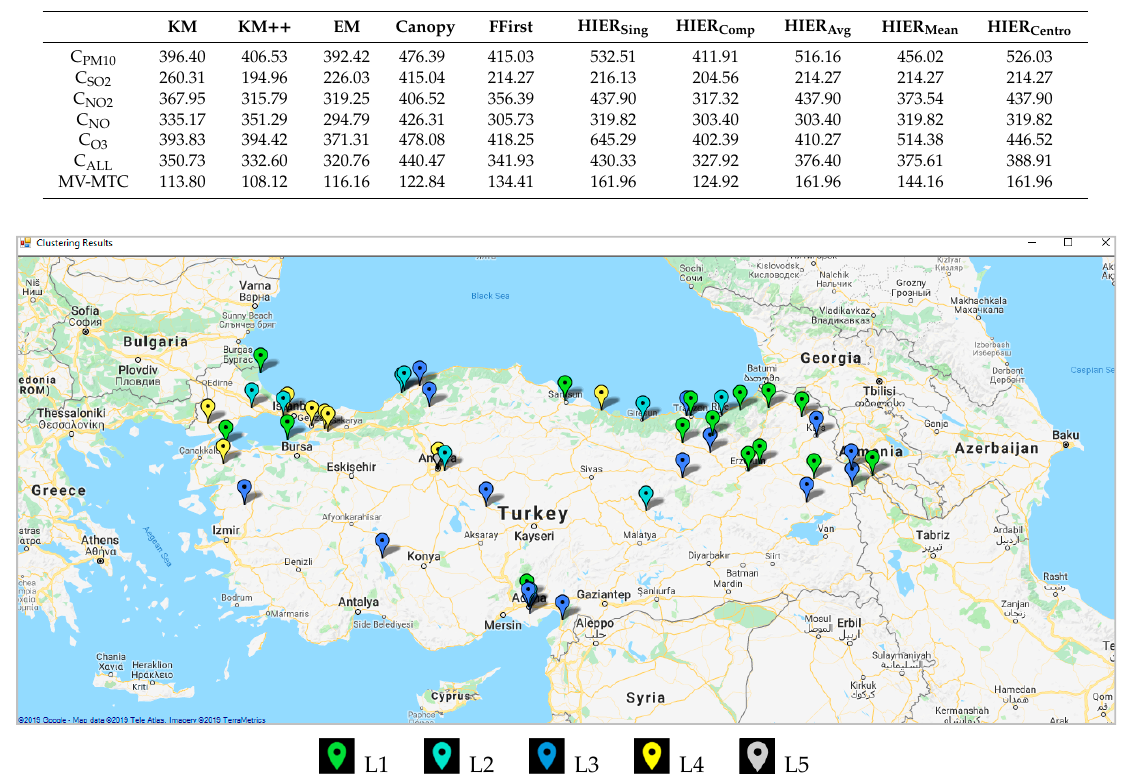
Figure 2. Results from the implementation of multi-task clustering obtained by KM++.